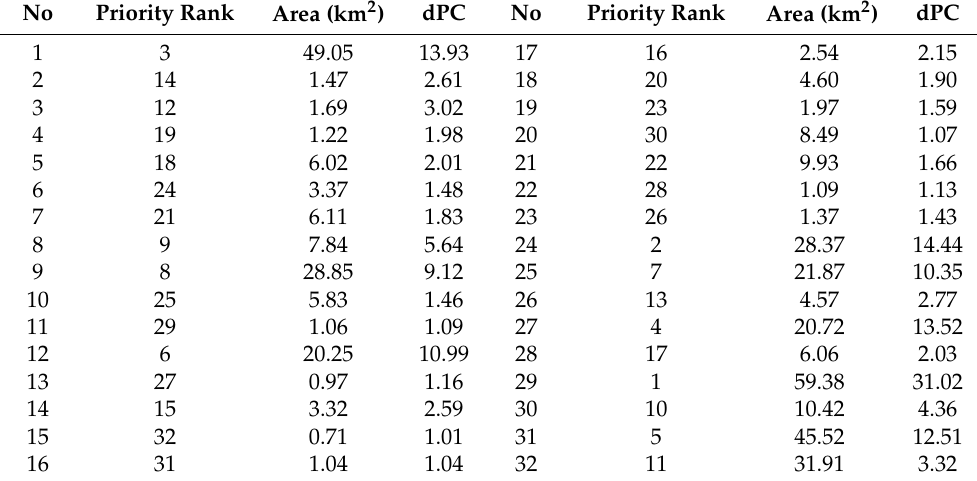
Table 4. Priority evaluation of